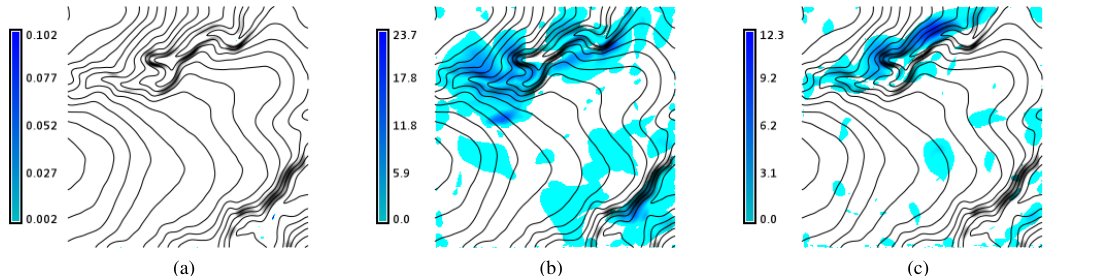
Figure 6: (a) The depth of depressions in the reference landscape, (b) the maximum depth of depressions using digital modeling, (c) and the maximum depth of depressions using tangible modeling